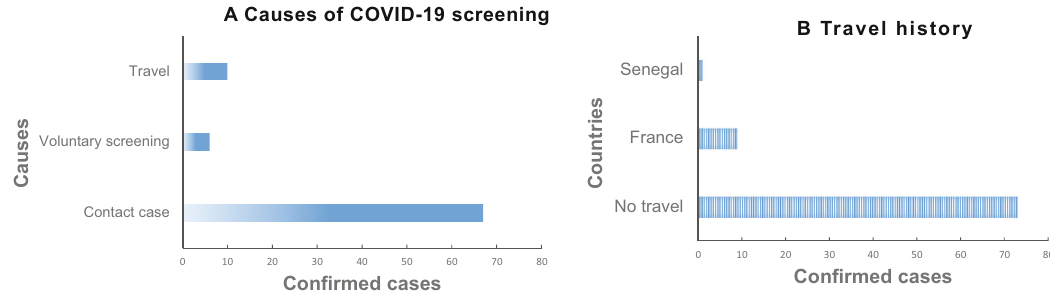
Figure 1. (A-B): Context of COVID-19 screening. A. Causes of COVID-19 screening. B. Travel history of confirmed